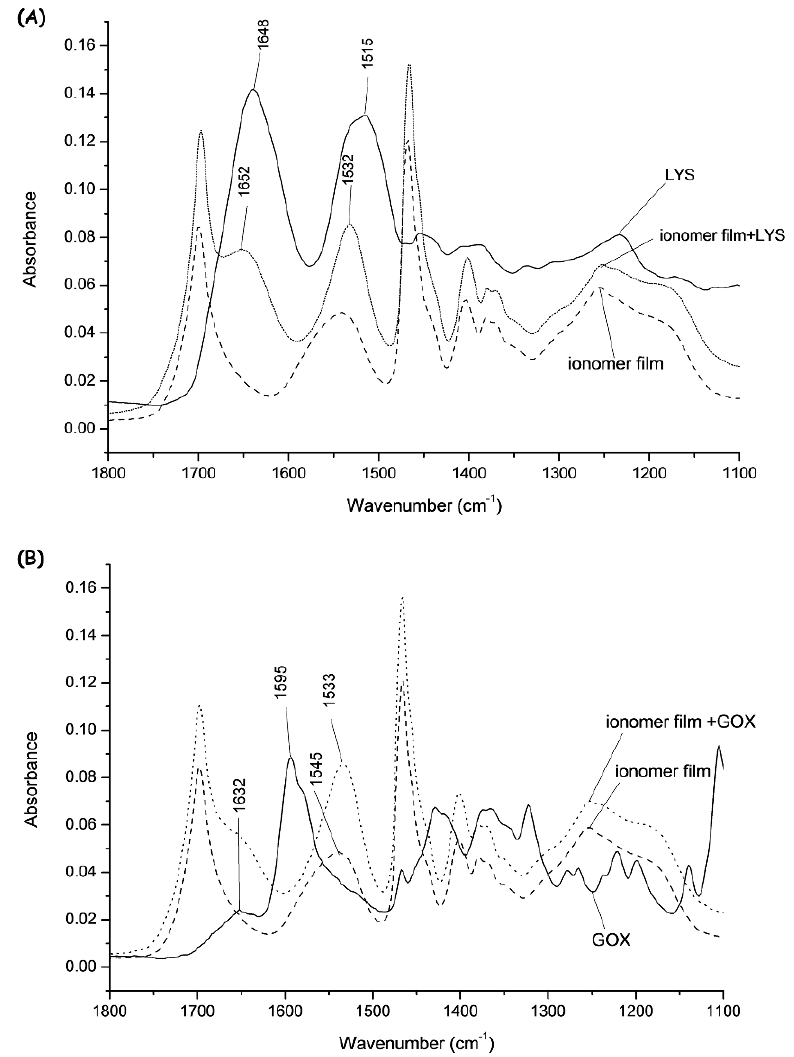
Figure 1. FTIR spectra of ionomer film with immobilized lysozyme (A) and glucose oxidase